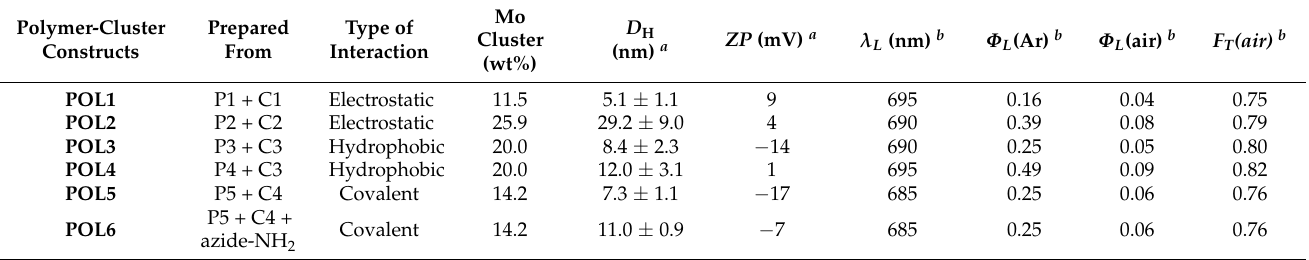
Table 3. Physico-chemical and photophysical characteristics of polymer-cluster